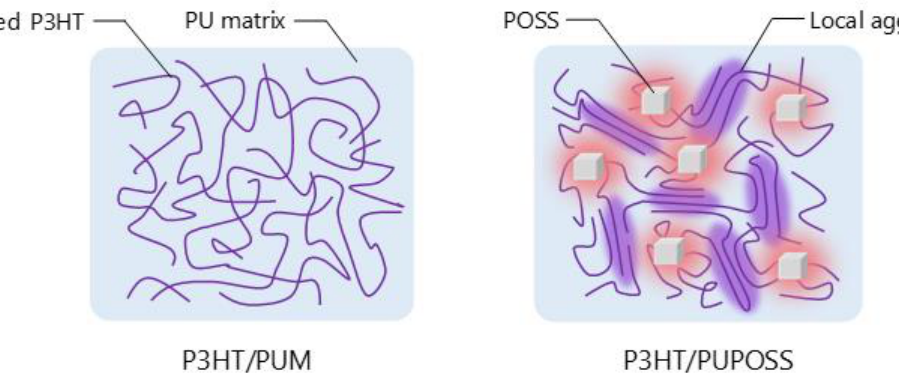
Figure 4. Illustration of the plausible mechanism regarding enhancement of conductivity by POSS.